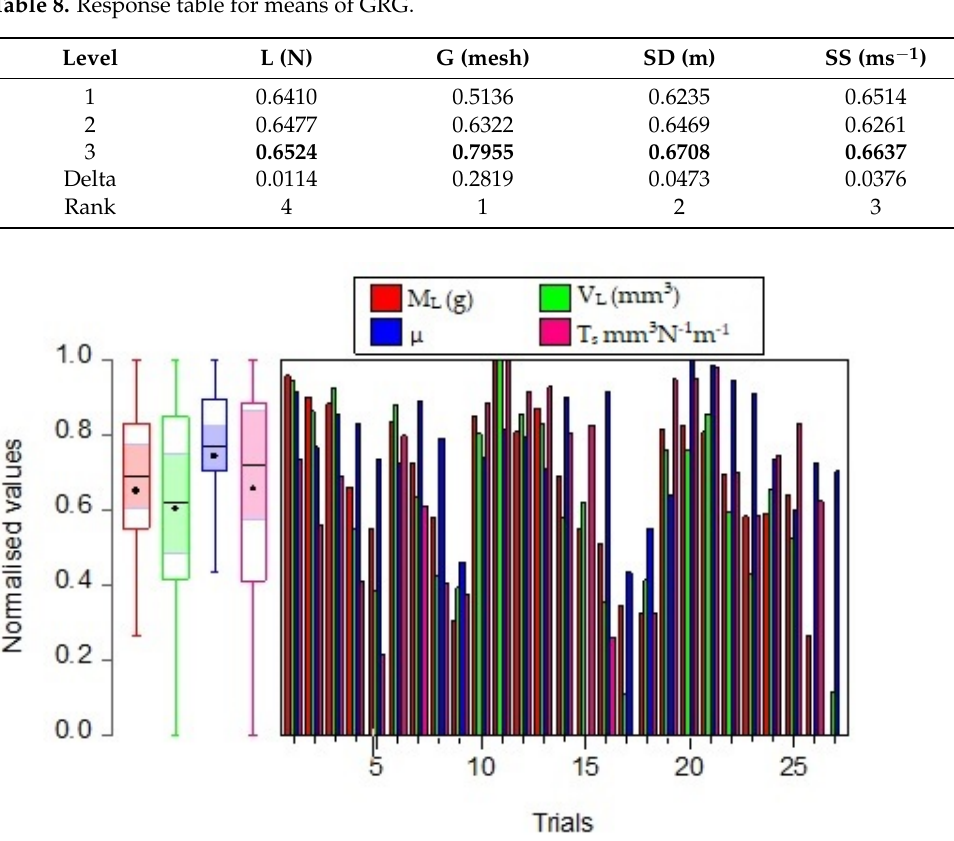
Figure 16. Deviation sequence for the L 27 (3 4 ) hybrid Taguchi–OA. T s (mm 3 N − 1 m − 1 ) μ .